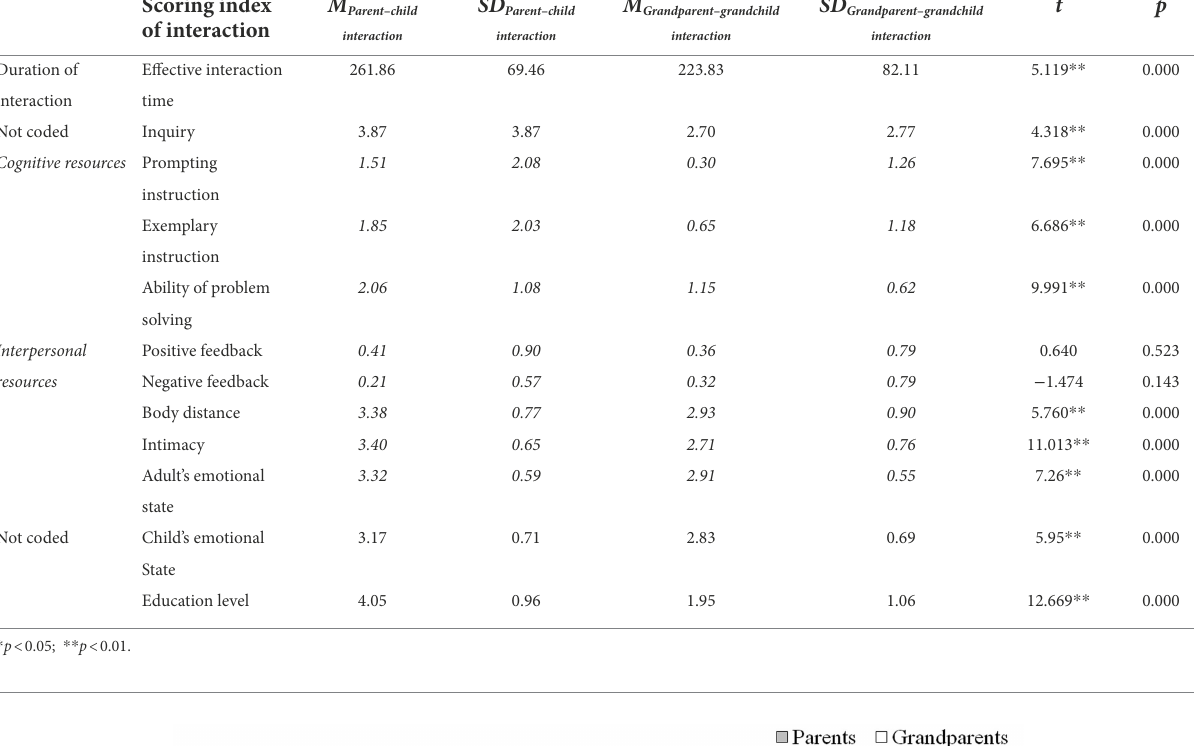
TABLE 3 Comparison of cognitive and interpersonal resources given by parent–child interaction and grandparent–child interaction (paired-sample t -test).